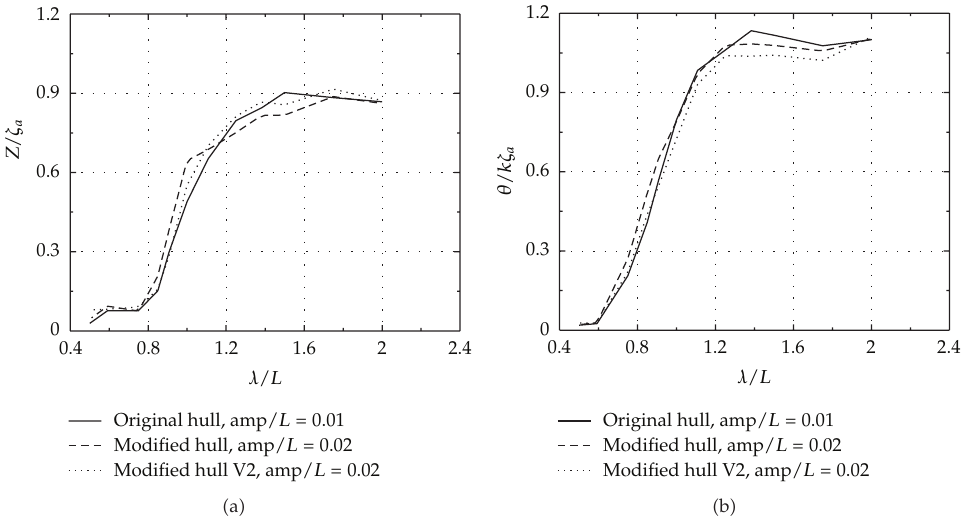
Figure 14: Heave and pitch amplitude of three di ff erent Wigley hulls; F n (cid:7) 0 . 2, Amp /L (cid:7) 0 .